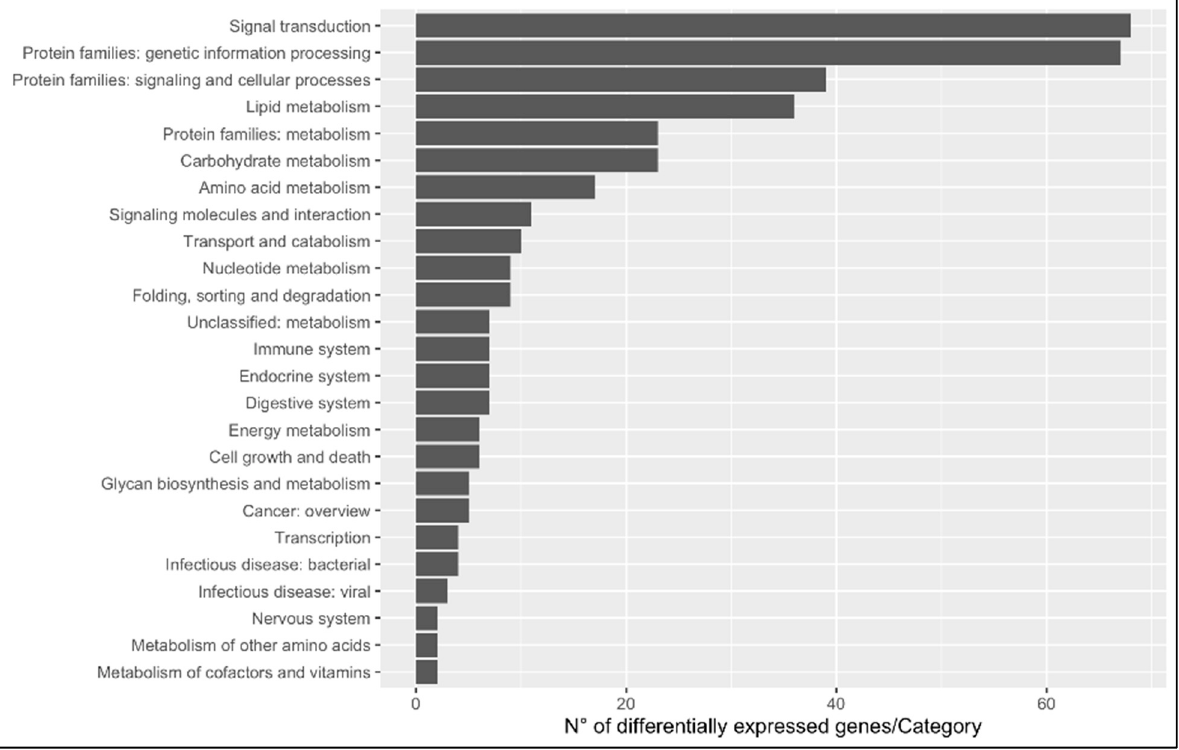
Figure 6. KEGG BRITE functional hierarchies analysis category B (intermediate category). The bar plot shows on x -axis the number of DEGs per intermediate category between livers of immature ( n = 3) and mature ( n = 3) females; y -axis indicates the pathway